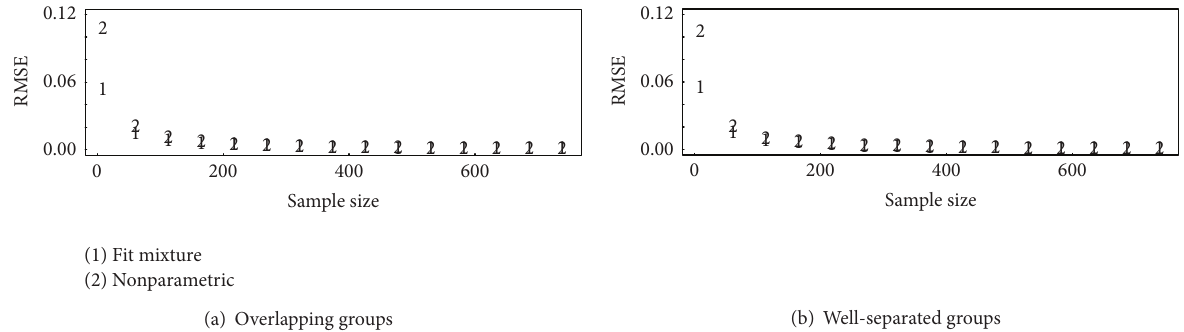
Figure 7: The RMSE versus sample size for (a) well-separated and (b) overlapping groups for a mixture of an unknown number of normals (same case as Figure 6, except the number of groups is unknown so it must be